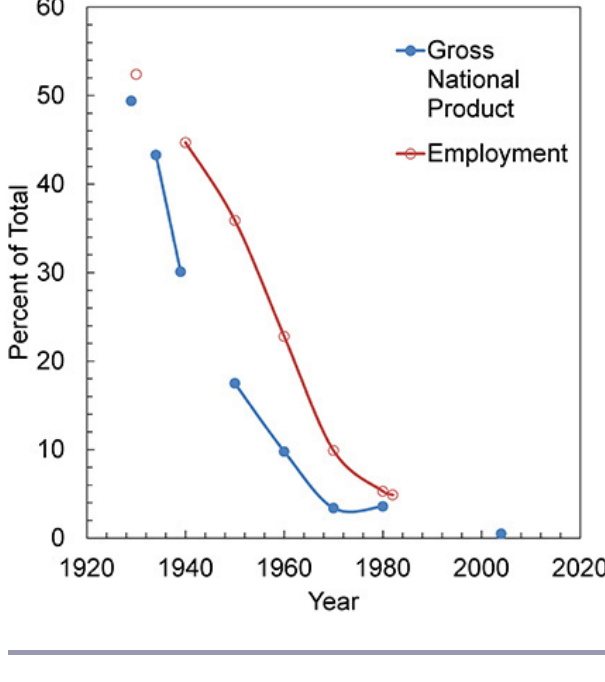
Fig. 2 . The history of decline of agricultural activity in Puerto Rico and of its contribution to the Island’s gross national product. This is based on official records of the Puerto Rico Agriculture Department.